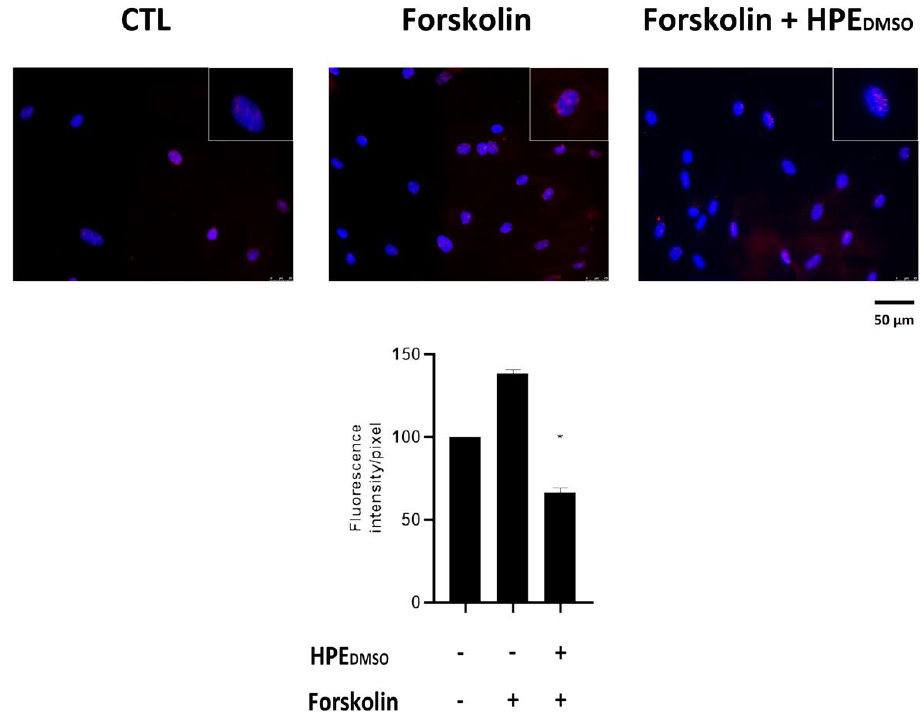
Figure 3. Effects of HPE DMSO extract on PKA phosphorylation after forskolin stimulation. Cells were treated with forskolin for 30 min or pre-treated with HPE DMSO for 1 h and then stimulated with forskolin for 30 min. Cells were analyzed by immunofluorescence using anti- p -PKA primary antibody and Alexa Fluor 568 (red) secondary antibody. Nuclei were stained with DAPI (original magnification 40×). The graph represents the pixel intensities in the region of interest, obtained by ImageJ. * p < 0.05 vs. CTL.